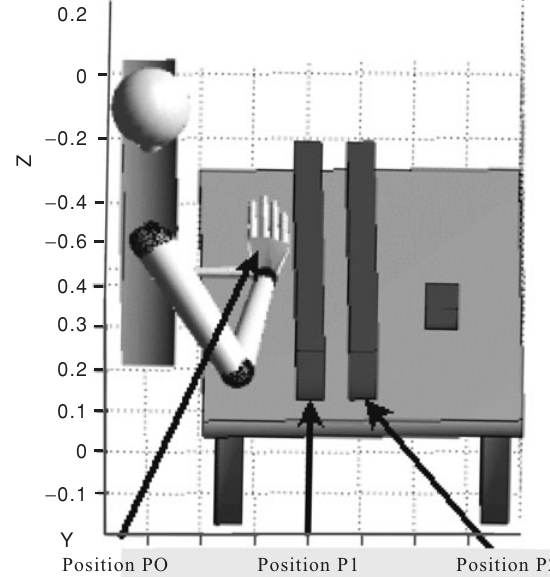
Figure 1 Experimental protocol representation. elbow trajectories. Figures 2 and 3 represent respectively the wrist and the elbow trajectory for the six conditions (obstacle height: 10, 15, 20 cm; Position P1 and